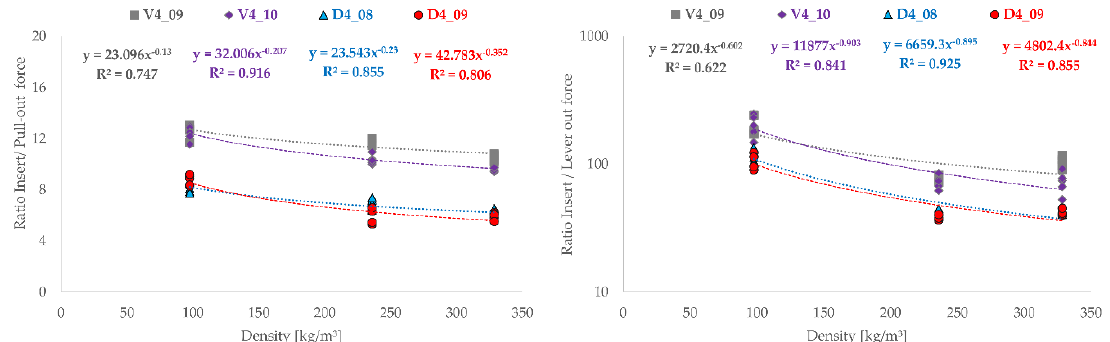
Figure 4. Representation of press-in ratio to the forces determined experimentally for the pull-out test and lever-out test in comparison to the material density (SikaBlock = 236 kg/m³, Sawbones = 328.6 kg/m³ and ROHACELL = 97.6 kg/m³) of the artificial bone cavities (n= 5).